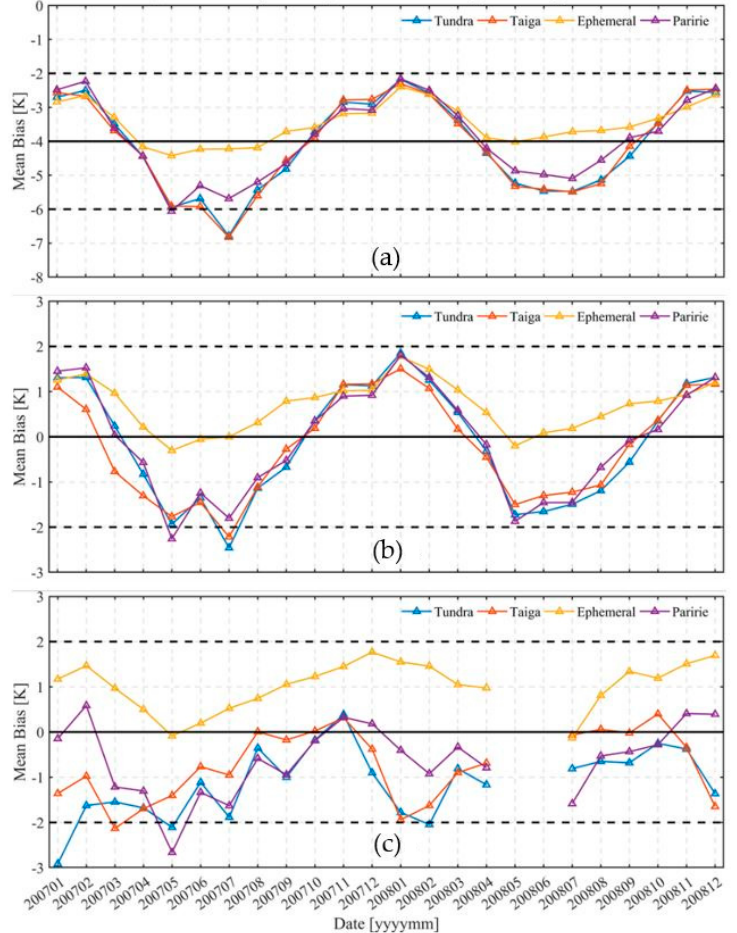
Figure 14. Time series of biases between SSM / I and SSMIS for four snow climate classes: ( a ) 19 GHz; ( b ) 37 GHz; and ( c ) 85 / 91 GHz.